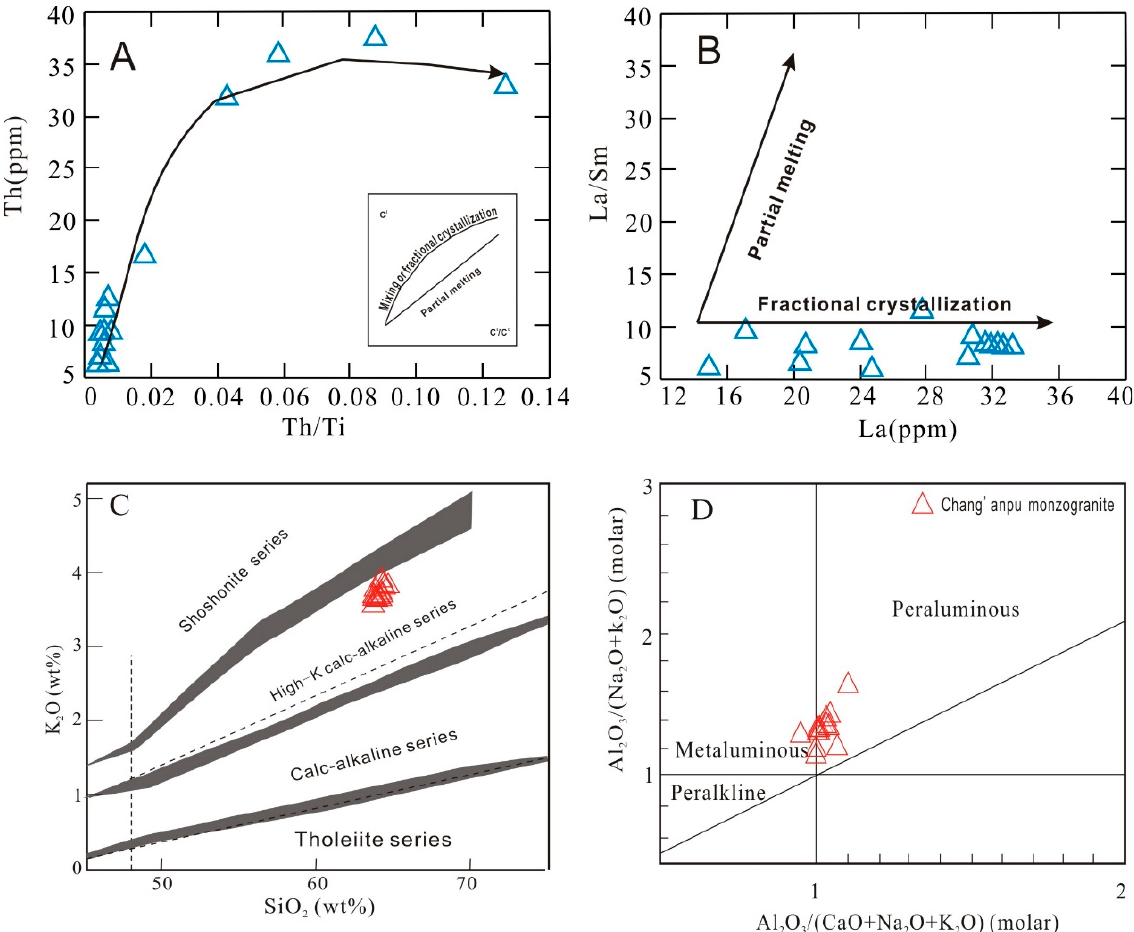
Figure 8. Petrogenetic diagrams for the monzogranite. ( A ) Th vs. Th/Ti diagram (Schiano et al., 2010) [89]. ( B ) La/Sm vs. La diagram [94]. The inset is aschematic C I versus C I /C C diagram (C I , incompatible element concentration, and C C , compatible element concentrations). ( C ) Diagrams of SiO 2 vs. K 2 O. ( D ) A/CNK vs. A/NK. The boundary lines in the SiO 2 vs. K 2 O and A/CNK vs. A/NK diagrams are from Peccerillo and Taylor (1976), and Maniar and Piccoli (1989) [95,96], respectively. The symbols are the same as in Figure 7.